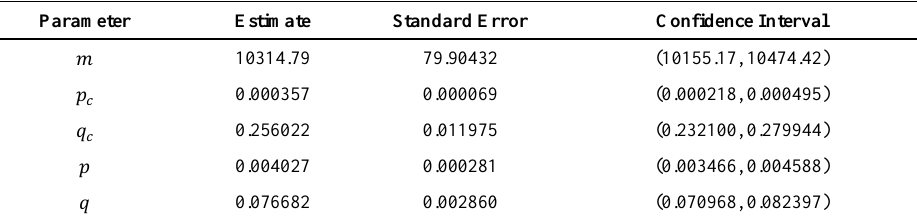
Table A22. Tuscany. Estimates, asymptotic standard errors and 95% mCIs for the parameters of the DMP (8).